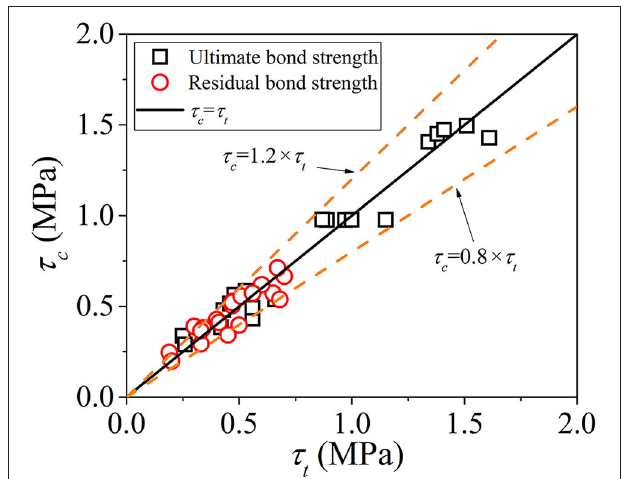
FIGURE 10 | Comparison of test and calculated